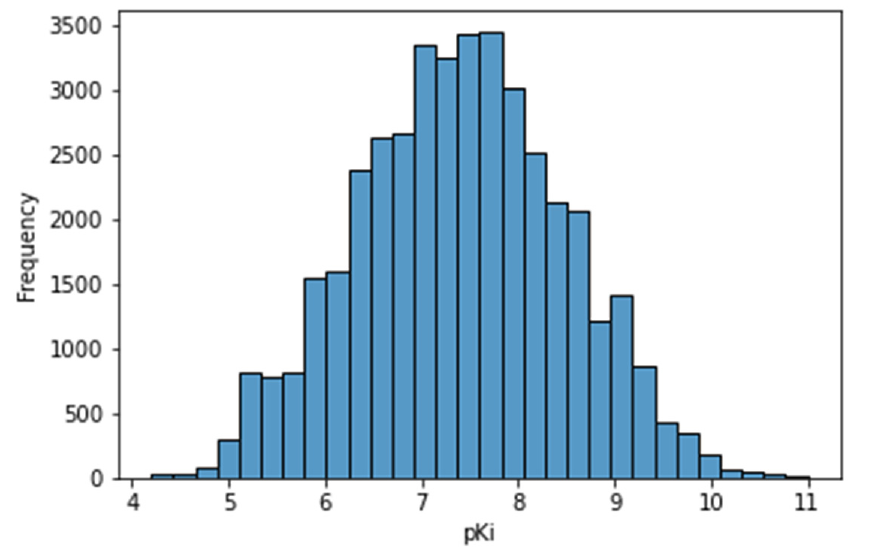
Figure 3. Histogram of pKi value in the curated database. According to the calculated Tanimoto similarity coefficient by the RDKit package, the similarity of the compounds to each other was within the range of 0.1553–1.0 for the curated database (median = 0.37). The pairs of compounds with a similarity equal to 1 are considered stereoisomers [23]. Figure 4 illustrates the distribution of the similarity value from the Tanimoto coefficient for 5-HT1A receptor ligands.